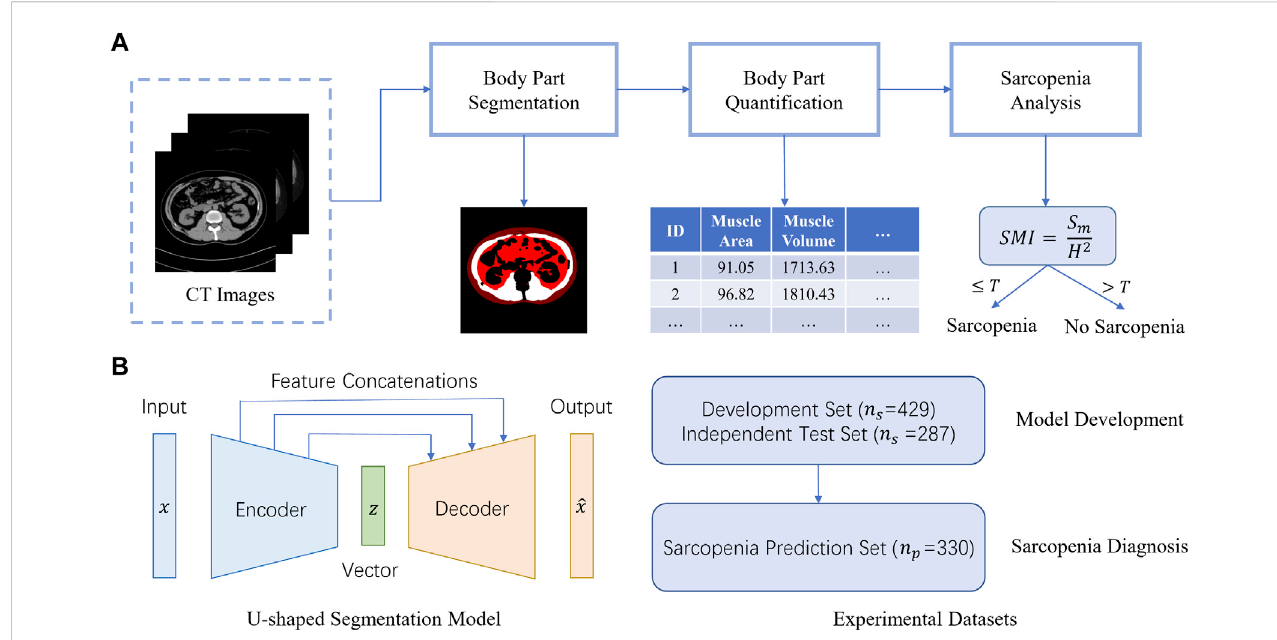
FIGURE 1 AIBMSforsarcopeniadiagnosis. (A) OverviewoftheAIsystem.Thesystemconsistsofthreemodules:amoduleforbodypartsegmentation,amodulefor body part quanti fi cation, and a module for sarcopenia analysis. S m is the muscle tissue area, H is the height, and T is the threshold of the SMI. (B) U-shape encoder-decoder structure (left) and experimental datasets